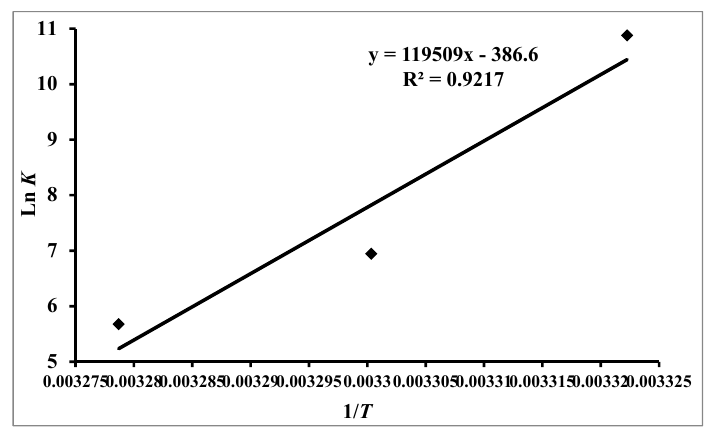
Figure 3. Van’t Hoff plot for the determination of thermodynamic parameters of RT–hTf interaction: The x -axis depicts the inverse of temperature in consideration while the y -axis shows natural log of the obtained binding constant obtained at these temperatures. Table 2. Thermodynamic parameters obtained for RT–hTf interaction as calculated from fluorescence spectroscopy quenching experiments.